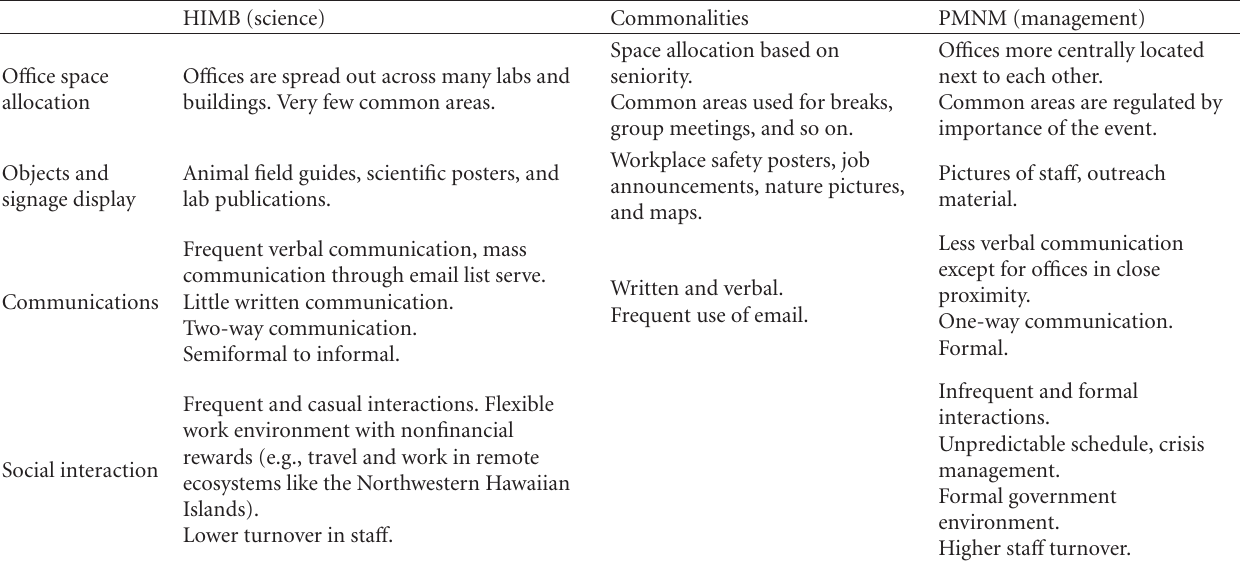
Table 1: Science management organizational culture